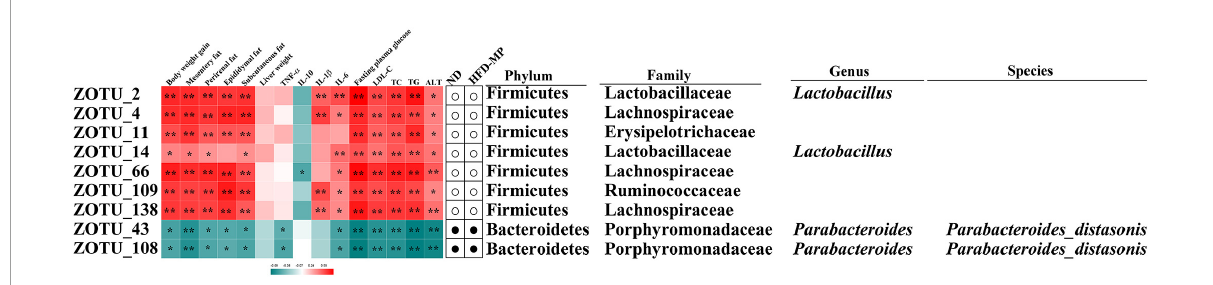
FIGURE8 Nine ZOTUs reversed by MP intervention were significantly correlated with features of obesity. The heatmap shows the R -value of Spearman’s correlation between the relative abundance of ZOTUs and features of obesity. The dots (correlation between the more or less relative abundance of ZOTUs in the ND or MP groups compared with the HFD group. * and **Show the significant associations ( p < 0.05 and p < 0.01, respectively) based on Spearman’s correlation